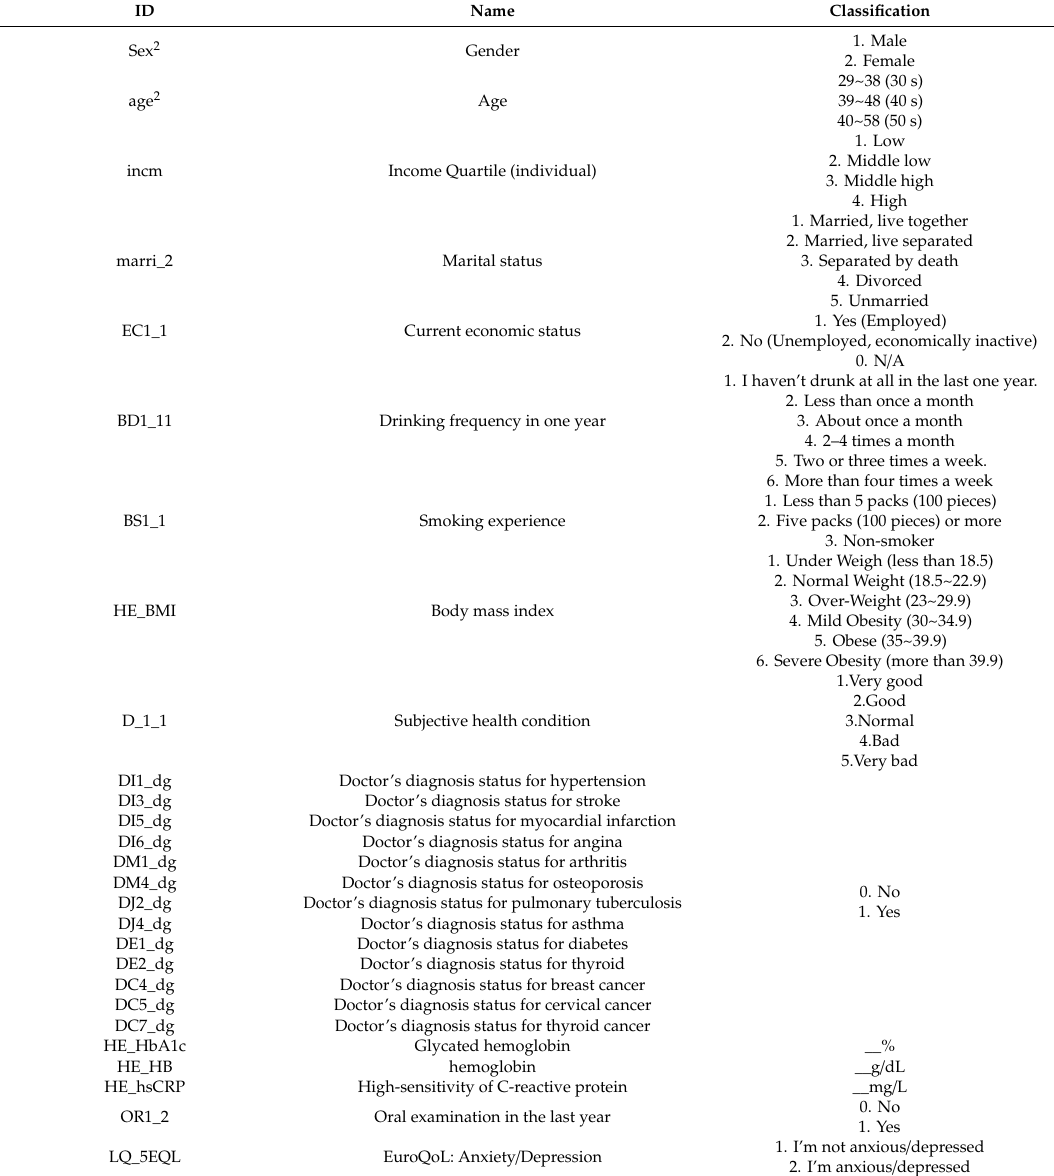
Table A1. Variables used for analysis extracted from the Korea National Health and Nutrition Examination Survey (KNHANES) dataset based in South